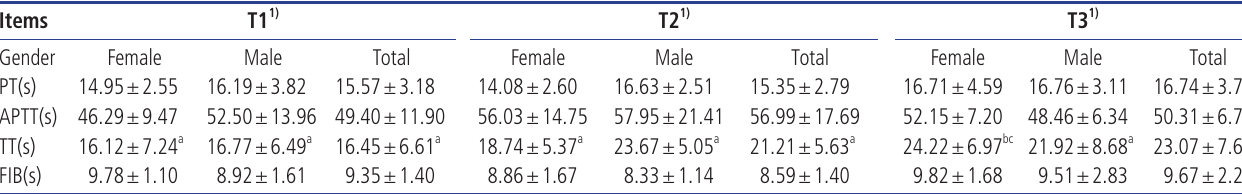
Table 4. Effect of mulberry leaves on coagulation parameters of Sprague-Dawley rats at the end of the treatment period Items